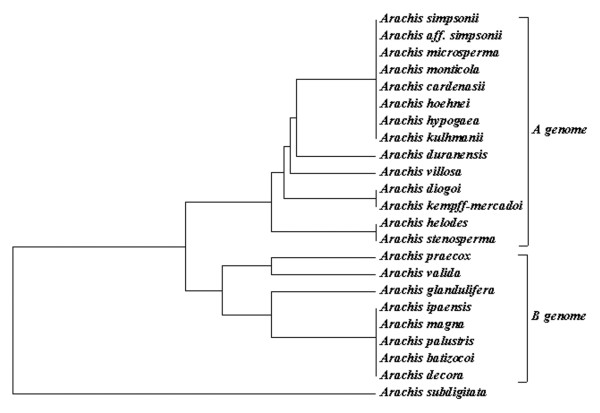
Phenogram showing the relation among Arachis species based on amplification events obtained using eight primer pairs and 22 Arachis species. The polymorphism was not enough to characterize most species, but they were grouped according the type of their genomes (A, B and D).